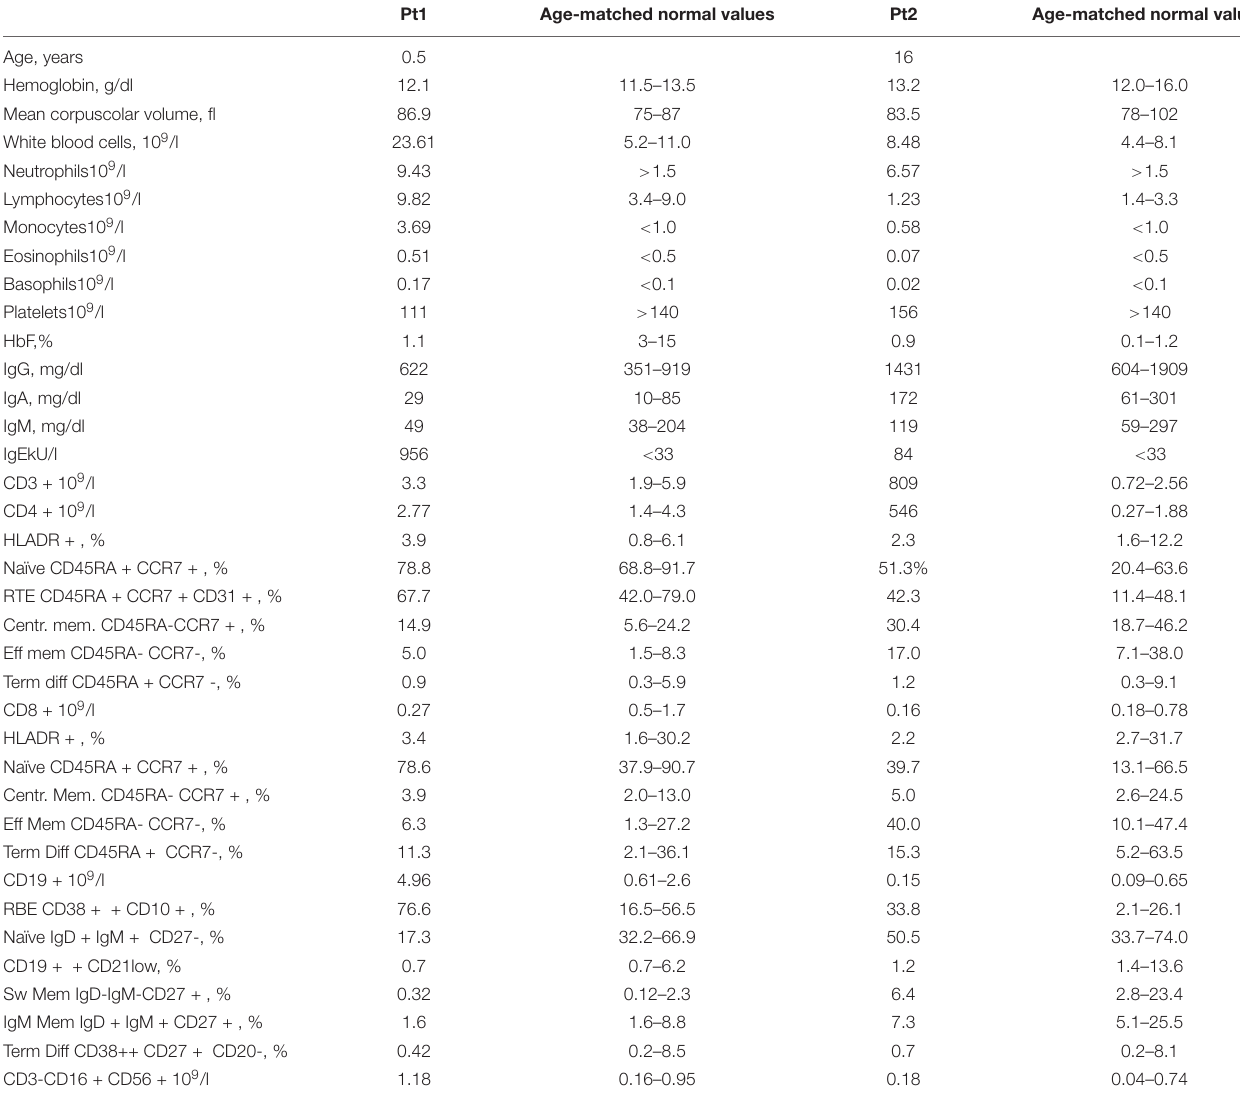
TABLE 1 | Patient characteristics at the time of first